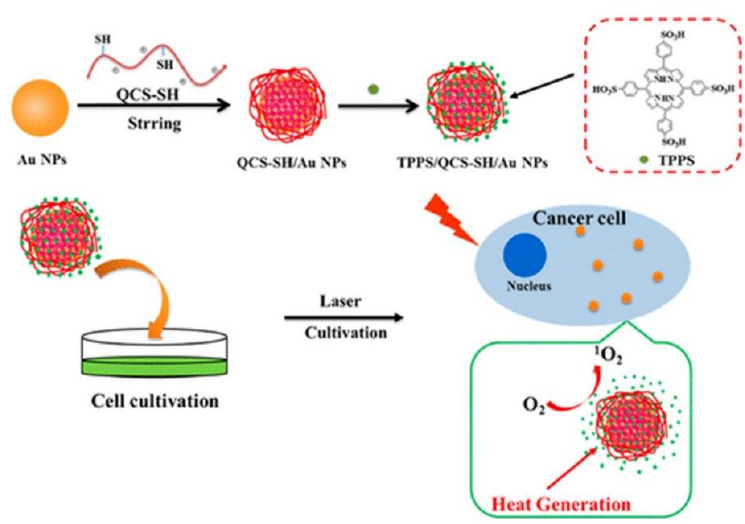
Figure 1. Proposed fabrication of meso-tetrakis (4-sulphonatophenyl) porphyrin (TPPS) / QCS-SH / gold nanoparticles (AuNPs) for dual mode photodynamic therapy (PDT) / photothermal therapy (PTT) treatment of cancer. Reprinted with permission from ref. [58]. Copyright 2018 American Chemical Society.